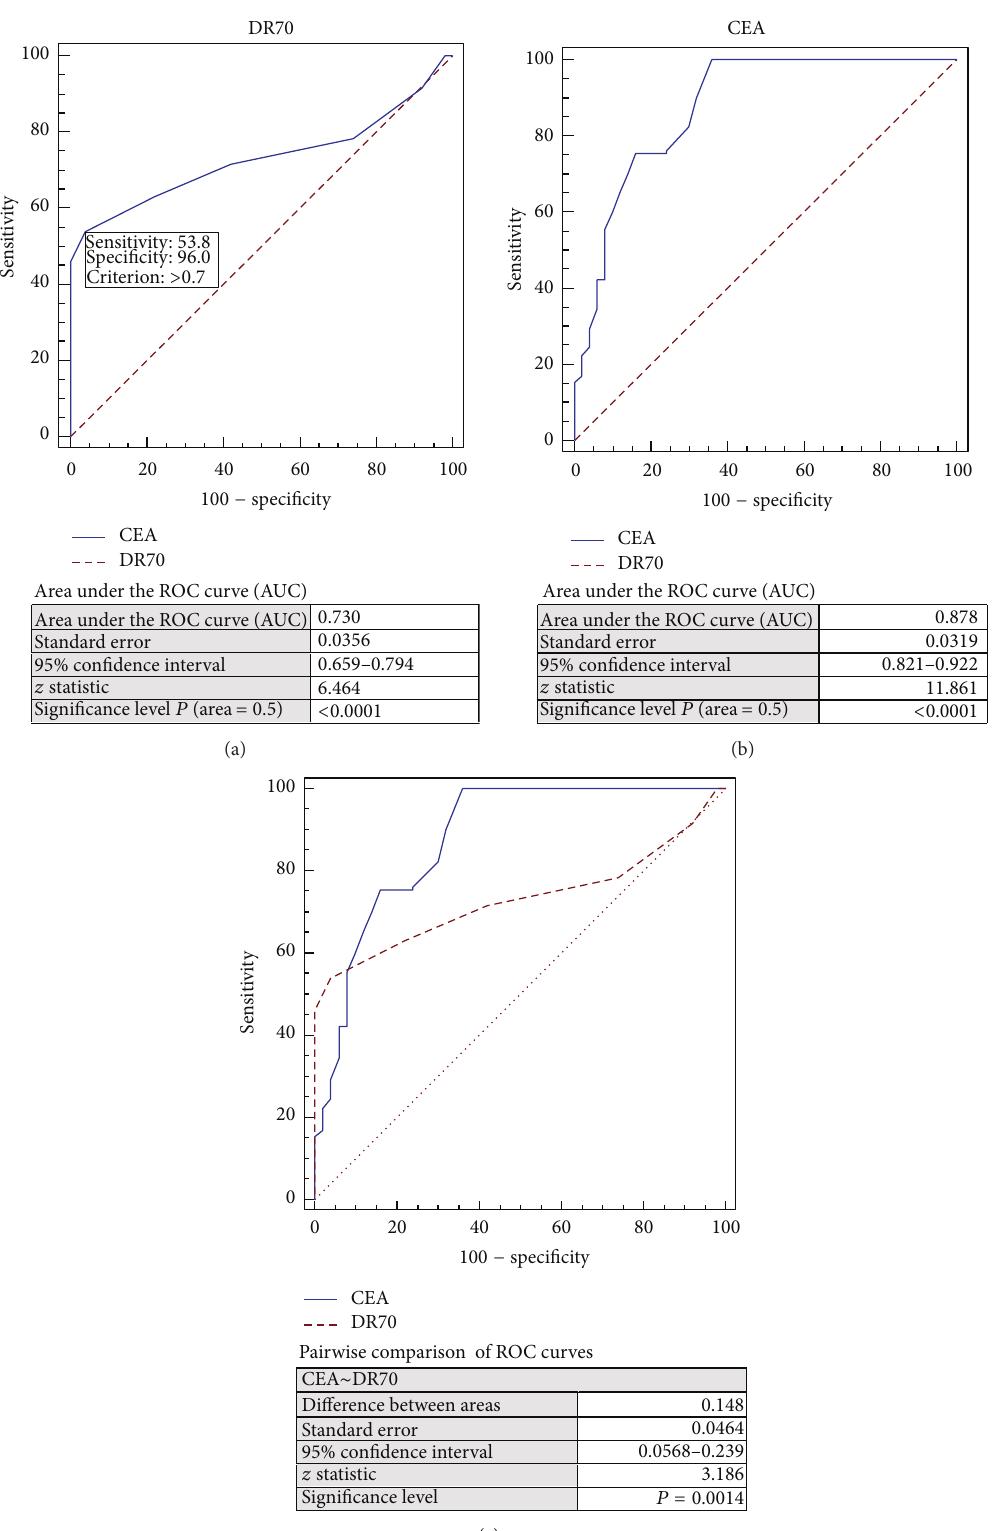
Figure 1: Receiver operating characteristic (ROC) curve for the diagnostic ability of (a) DR-70, (b) CEA, and (c) DR-70 versus CEA to differentiate the presence of dysplasia from the healthy